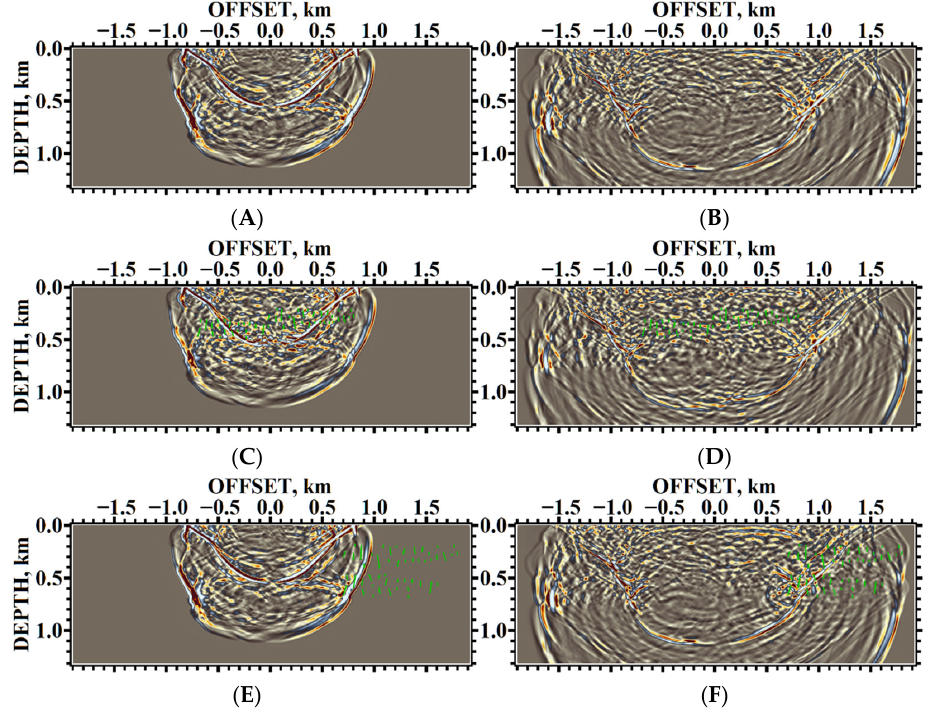
Figure 34. Example #5, horizontal component of velocity snapshot: ( A , B ) «without fractures», time of 0.275 s ( A ) and time of 0.51 ( B ); ( C , D ) «fractured zone #1», time of 0.2784925 s ( C ) and time of 0.516477 ( D ); ( E , F ) «fractured zone #2», time of 0.2695 s ( E ) and time of 0.4998 s ( F ).